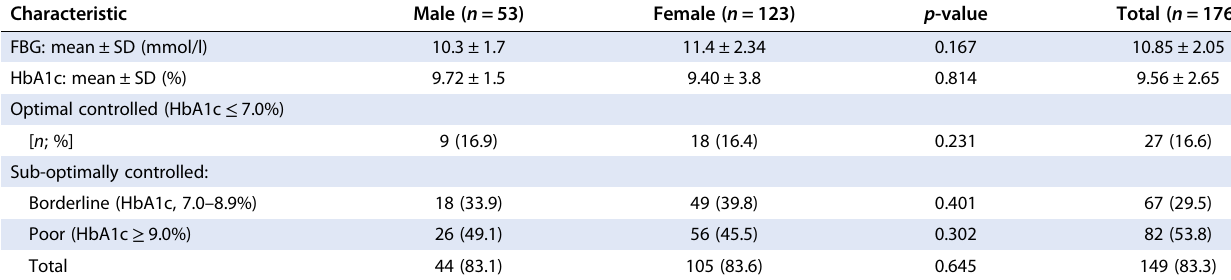
Table 2: Glycaemic control status of the study subjects stratified by gender Characteristic Male ( n = 53)